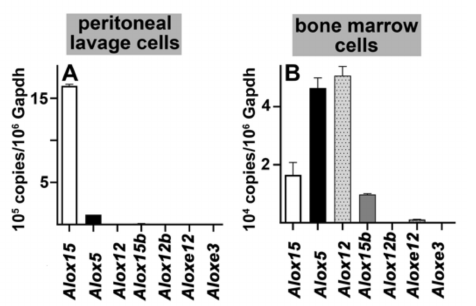
Figure 1. Expression of Alox mRNAs in peritoneal lavage and bone marrow cells of wildtype